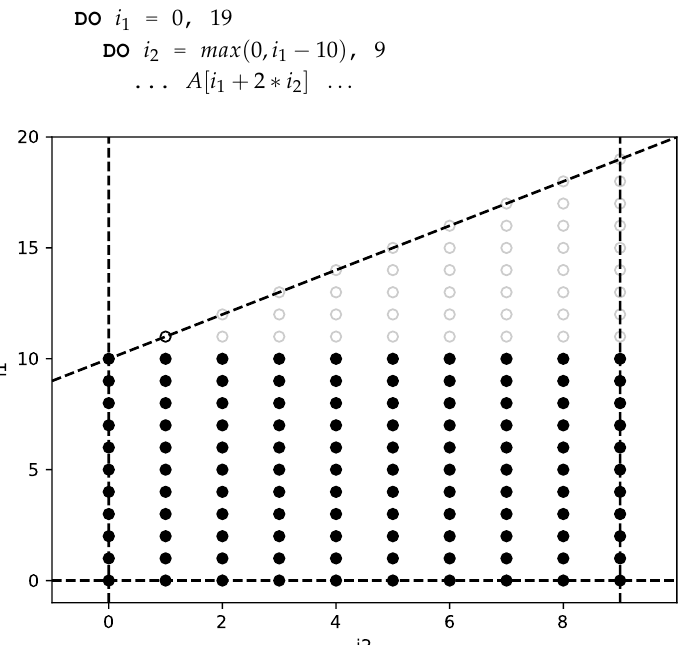
Figure 9. Example of iteration polyhedron with two different lower bounds hyperplanes associ- ated to i 2 . It corresponds to a loop using two different affine functions, f 1 and f 2 , combined as #» #» max ( f 1 ( ı ) , f 2 ( ı )) , in the lower bounds of the inner loop i 2 . The figure illustrates the state of the re- construction of the iteration polyhedron upon reaching iteration vector apparent that a new lower bounds face is needed to model the